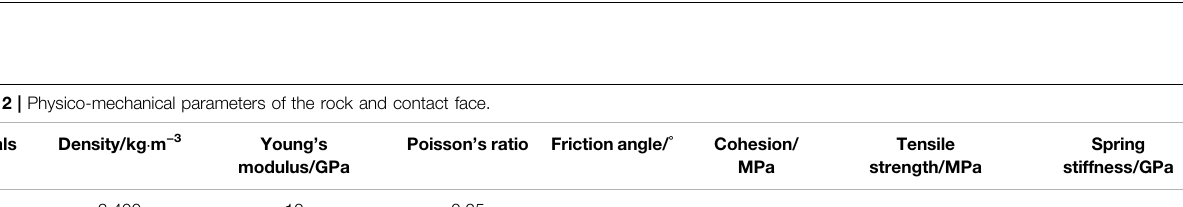
Figure 13 demonstrates simulated velocity in the Z -direction and the kinetic energy of the rock block. The overall trend of the kinetic energy is increasing, but there are many falls, which is caused by collisions between the rock block and the sloping surface. The temporal variation of the